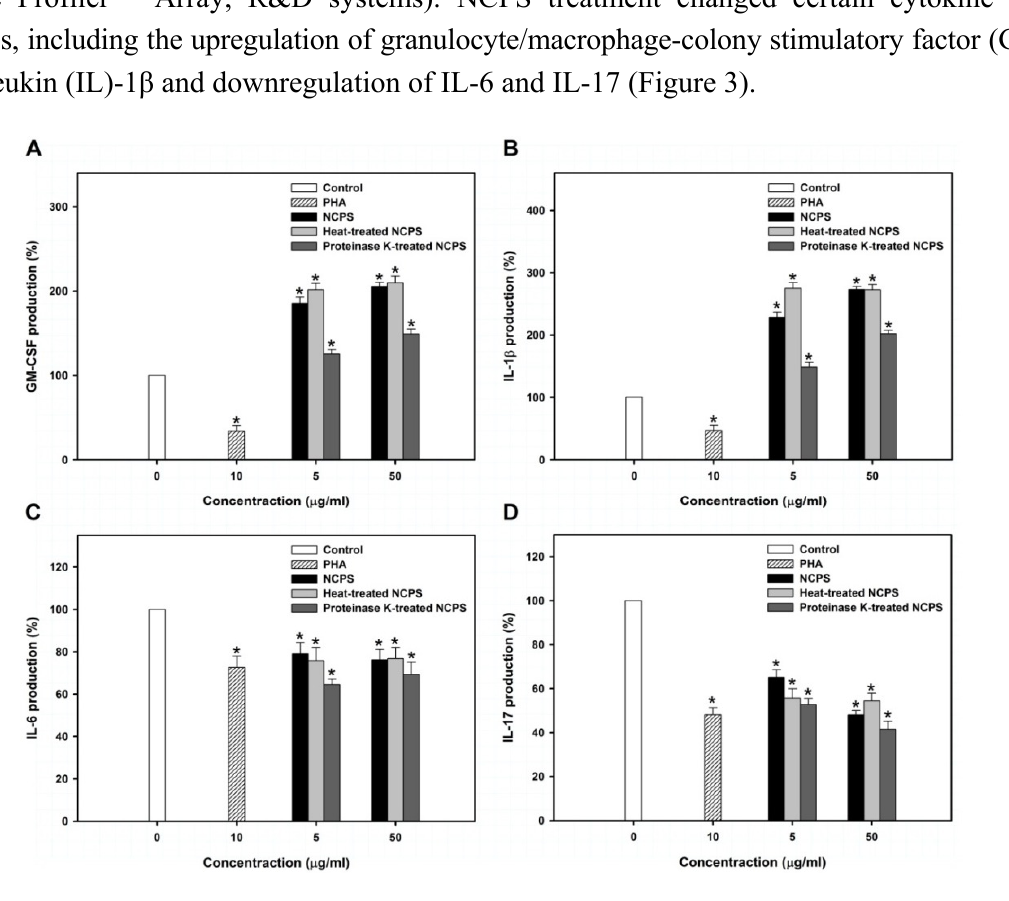
Figure 3. Levels of GM-CSF ( A ), IL-1 β ( B ), IL-6 ( C ), and IL-17 ( D ) in MNC-CMs that were produced from MNC with the treatment of PHA, NCPS, heat-treated NCPS, and proteinase K-treated NCPS. Star indicates that there is a statistically significant difference between control and treatment groups ( p <